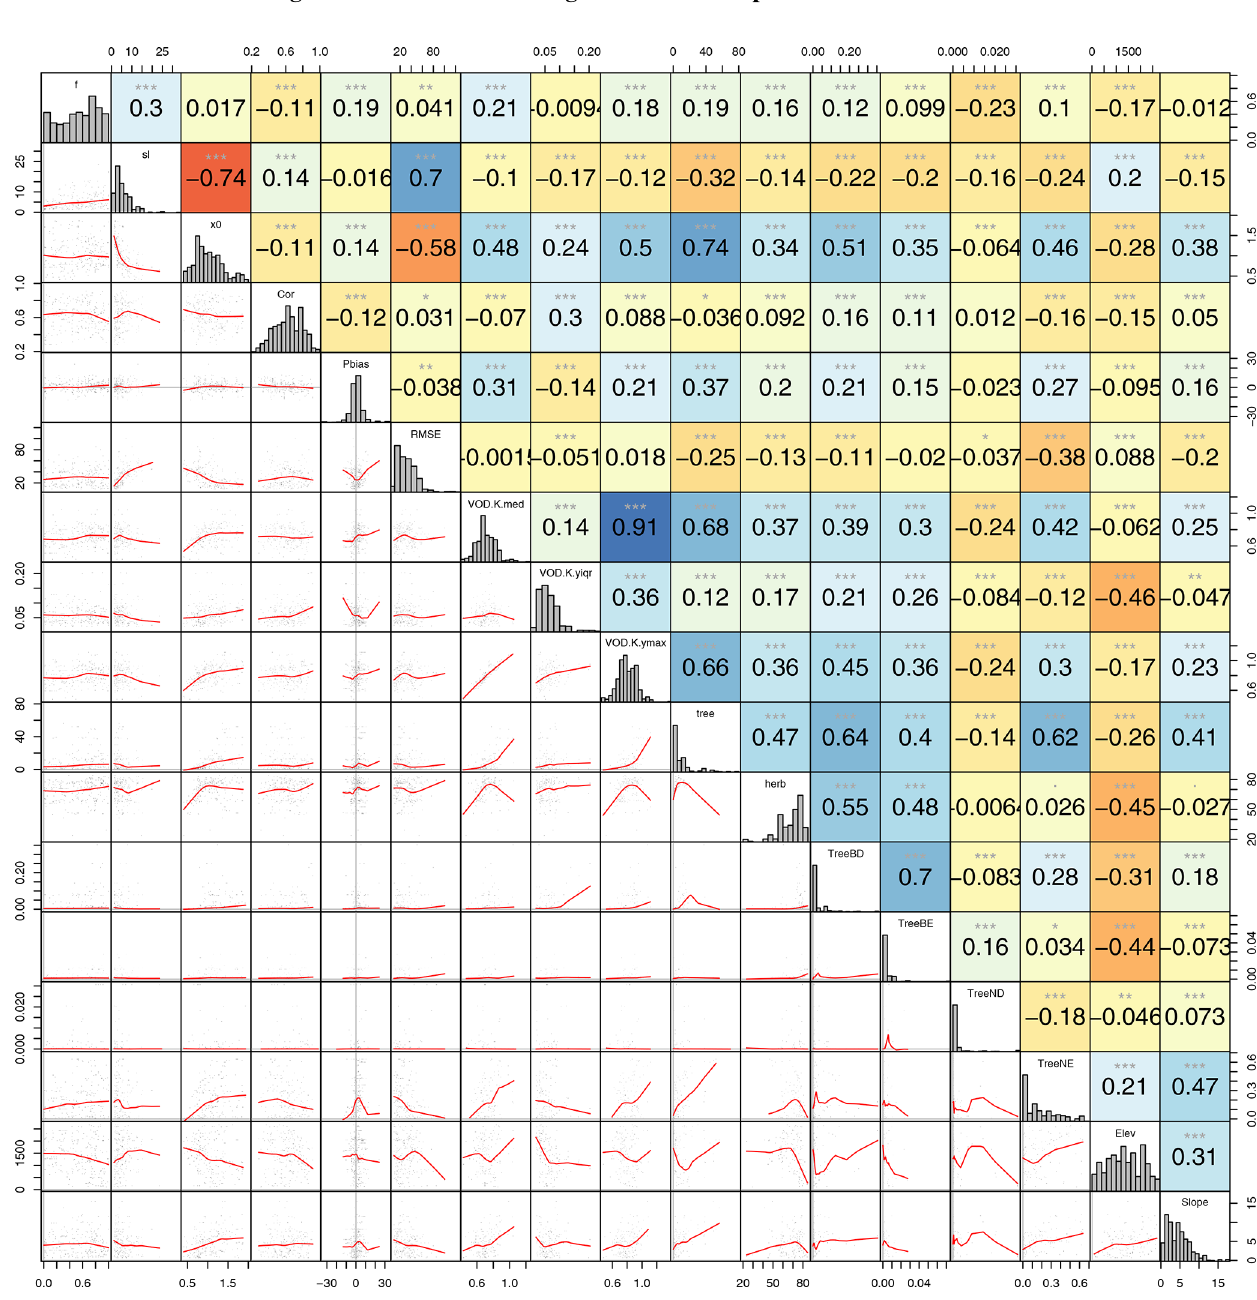
Figure A2. Across-site correlations between the site-optimized parameters f , sl, and x 0 of Model B with model performance measures and land cover properties of the corresponding 0.25 ◦ grid cells. Numbers and blue to red colours in the upper triangle display Spearman correla- tion coefficients. Red lines in the lower triangle are Loess fits between x and y values. Grey bars along the diagonal are histograms of each variable. Correlation (Cor), percent bias (Pbias), and RMSE of predicted and observed LFMC; temporal median of Ku-VOD (VOD.K.med); multi-year mean of the annual interquartile range of Ku-VOD (VOD.K.yiqr); multi-year mean of annual maximum Ku-VOD (VOD.K.ymax); tree and short vegetation cover from Song et al. (2018); tree cover of broad-leaved deciduous (TreeBD), broad-leaved evergreen (TreeBE), needle-leaved deciduous (TreeND), and needle-leaved evergreen (TreeNE) trees (ESA CCI Land cover V2.0.7 dataset); elevation (Elev) and slope from the CGIAR CSI SRTM digital elevation